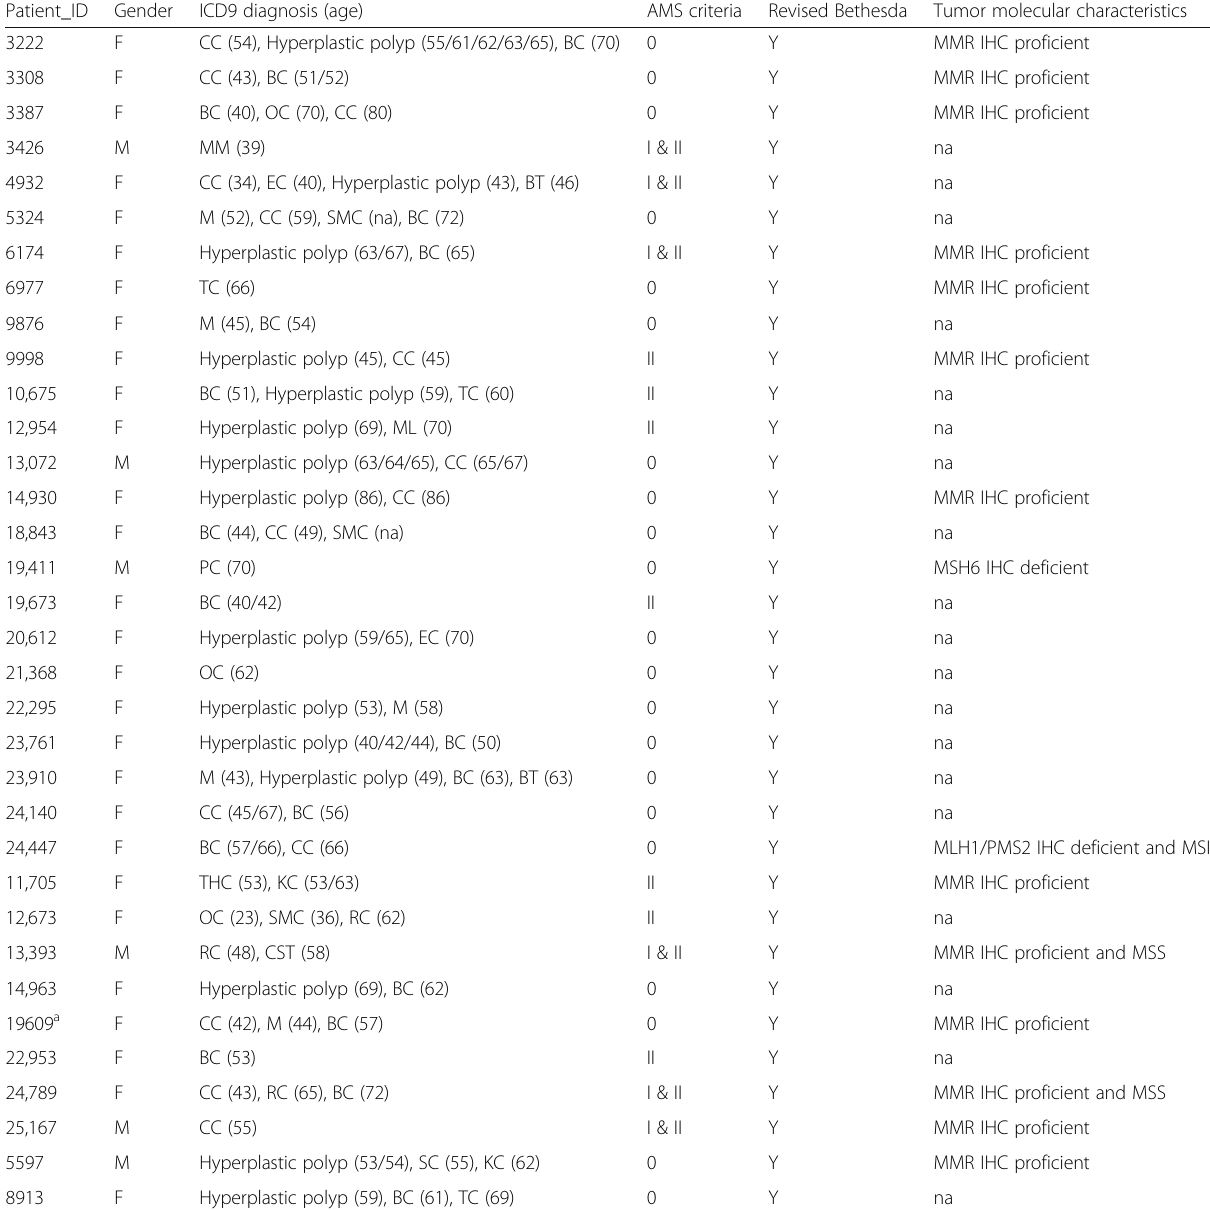
Table 1 Summary of International Classification of Diseases, 9th Revision (ICD9), gender, age at diagnosis, clinical criteria and tumor molecular characteristics of the familial CRC